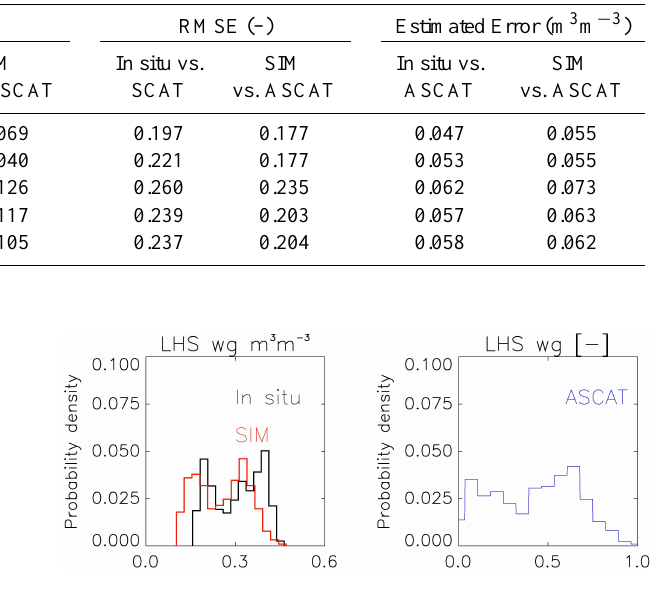
Fig. 5. Probability density function of SSM for the three data sets used in this study, (left) in situ and SIM (m 3 m − 3 ) and (right) AS- CAT (relative humidity) over a two year period 2007–2008 for the Lahas (LHS)